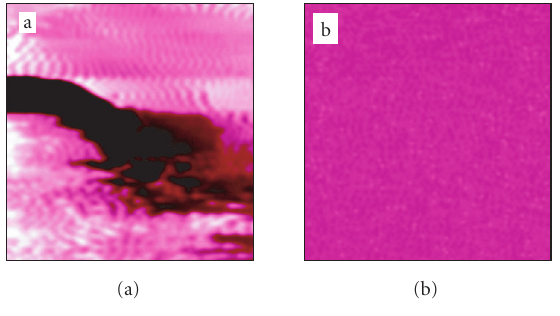
Figure 35: Shear-force AFM (a) (670nm, Z range 500nm) and si- multaneous apertureless SNOM (b) of a pristine blood bag surface purposely at an unusually rough site showing no optical contrast despite the topography due to homogeneous composition.